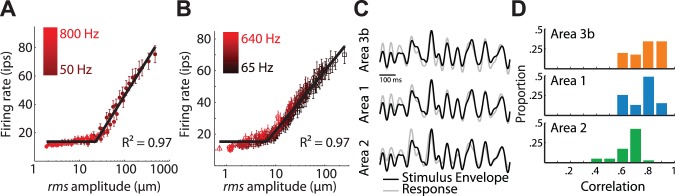
Stimulus amplitude versus firing rates.(A) Mean rate-intensity function for neurons in area 3b, computed from responses to sinusoids; marker colors change from dark to bright red with increasing stimulation frequency; error bars denote standard error of the mean. The shallow and frequency-independent increase in firing rate at low amplitudes is due to progressive neuronal recruitment and is not observed in the responses of individual neurons (see Figure S1A). (B) Rate-intensity function for neurons in area 3b, computed from responses to band-pass noise stimuli; colors change from dark to bright red as the center frequency of the noise increases; markers denote different noise conditions (triangle, noiseA; circle, noiseV; square, noiseP, see Materials and Methods). For both individual neurons and neural populations, responses are independent of the frequency composition of the stimulus. (C) Hilbert transform of a sample noise stimulus (black) and smoothed time-varying population firing rates (gray) in areas 3b (top), 1 (middle), and 2 (bottom). The neural response is time-shifted to account for neural delays. (D) Mean correlation between the time-varying population response and the logarithm of the stimulus envelope in the three areas.